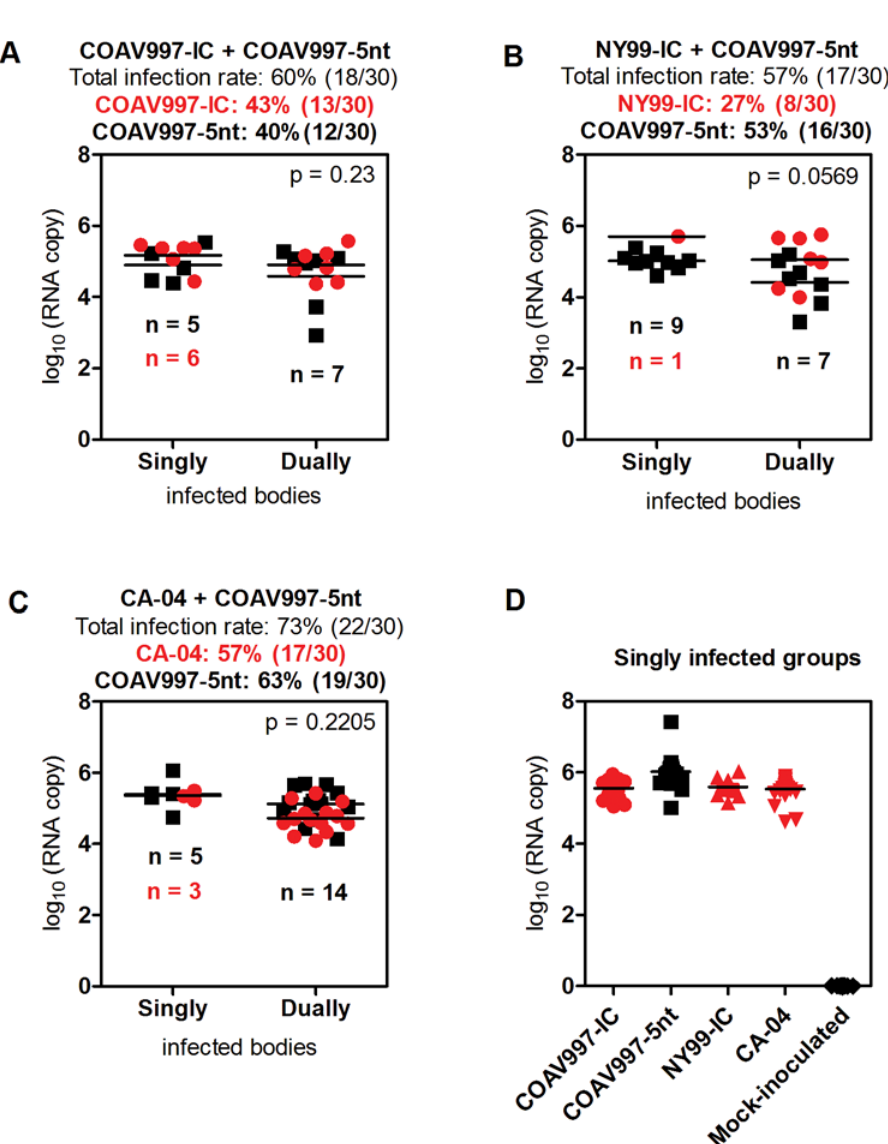
Fig 6. RNA copy numbers in Culex tarsalis bodies. RNA copy numbers as log 10 were determined in mosquito bodies by qRT-PCR. Panels A-C present the RNA copy numbers from mixed competition groups and panel D from the four singly infected groups with wildtype RNA in red color and COAV997-5nt RNA in black color. In panels A-C results were divided into bodies that tested positive for one virus (singly infected) or both viruses (dually infected), and the respective specific infection rates are listed on the right. The total infection rates indicate how many mosquitoes were tested positive by either of the qRT-PCRs and therefore combine numbers from singly and dually infected mosquitoes. For singly infected bodies in panels A-D, each dot represents the RNA value for one body, whereas two dots are referring to two RNA values obtained from one dually infected body in panels A-C. Horizontal lines indicate the mean RNA copy value for each group. The number of RNA-positive bodies is indicated in parenthesis and the infection rates shown as percent (%).